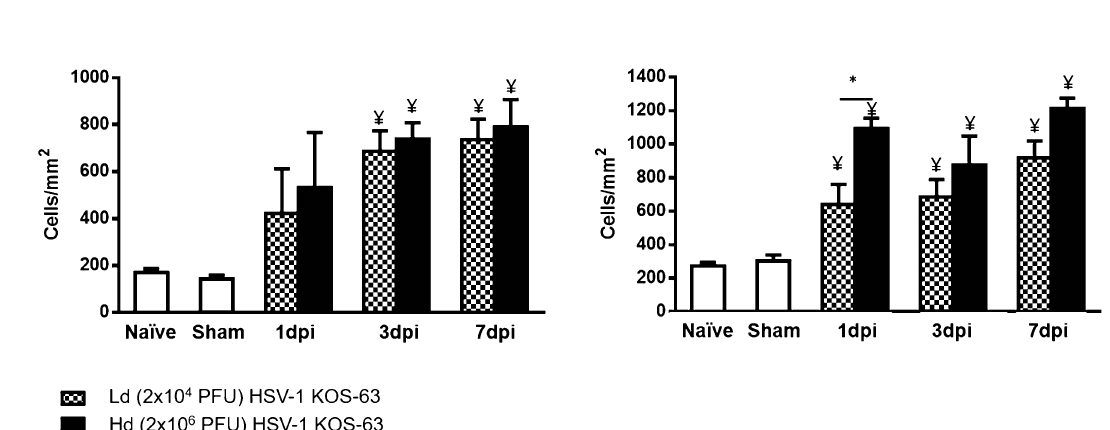
Figure 4. Number of CD45 + inflammatory cells in the central ( A ) and peripheral ( B ) cornea in naïve, sham- infected, Ld and Hd KOS-63-infected mice. Whole mount confocal images of corneas, which were stained with PE-conjugated rat anti-mouse CD45 (30-F11) antibody, were analyzed with IMARIS software to calculate the number of CD45 + cells in the cornea. At each post infection timepoint 3–9 corneas were stained. In addition, 6 and 9 naïve and sham-infected (1 day post scarification) corneas were stained, respectively. Bars are showing mean ± SEM. ANOVA: p < 0.0001; * p = 0.01, calculated by one-way ANOVA followed by Tukey’s multiple comparison test. ¥, demonstrates the statistical significance ( p < 0.05) between the marked column and the sham-infected constituted 3.5% of leukocytes (CD45 + cells) in naïve corneas, their percentage increased to 26.3% and 71.6% in the Ld and Hd infected mice, respectively. 41.1% and 90.6% of CD45 + cells expressed CD11b + in the Ld and Hd infected groups, respectively. In addition, F4/80 + cells constituted 25.7%, and 19.6% of CD45 + cells in Ld- and Hd-infected mice, respectively (Fig. 5). Furthermore, 74.1% and 28.7% of corneal CD45 + cells expressed CD11c + in Ld- and Hd-infected mice, respectively. Moreover, natural killer cells (CD45 + / NK-1.1 + ) were not detected in